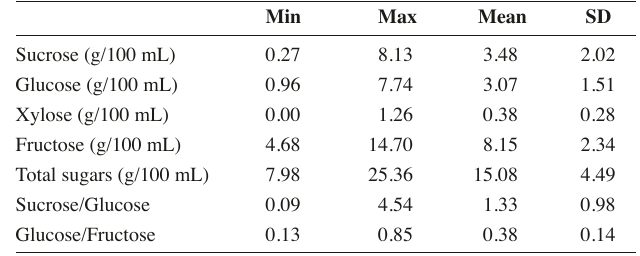
Tab. 2: Descriptive statistics for the variables of TA (total acid), Malic acid, Citric acid pH, and SSC (Soluble Solids Content ° Brix) of the 34 lo - cal accessions studied. For each trait, minimum, maximum and mean values and standard deviation (SD) are presented. %CV percent coef - ficient of variation